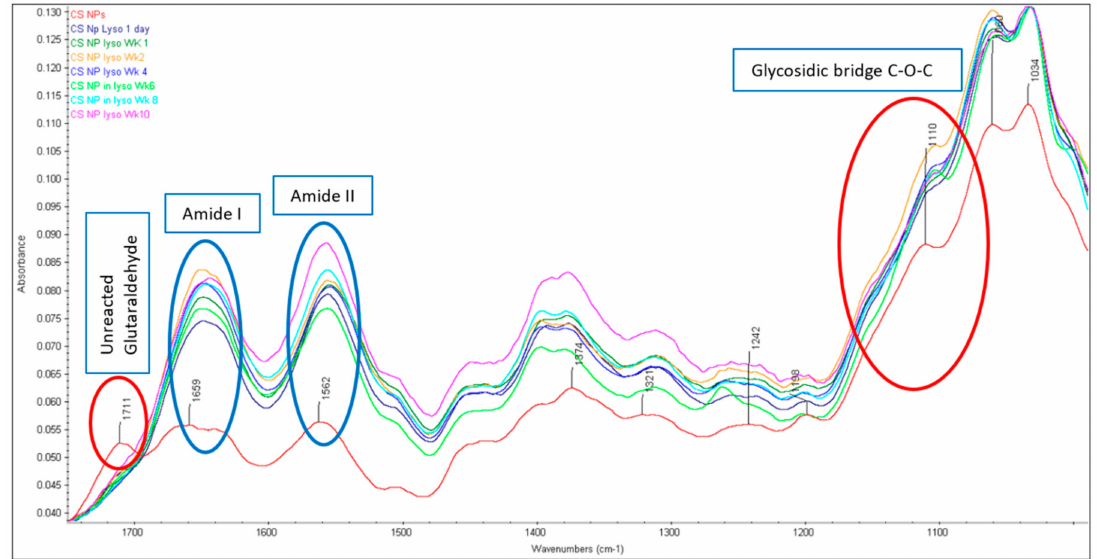
Figure 3. FTIR spectra of CS NPs before and after lysozyme treatment (characteristic peaks for amide I, II and glycosidic bonds are